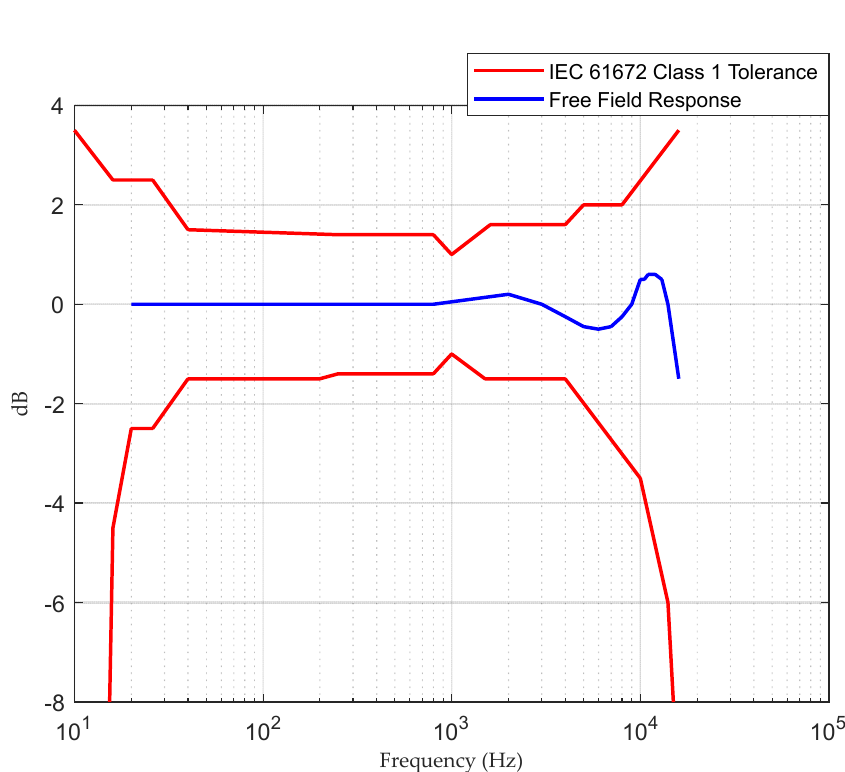
Figure 1. Frequency response of SAS 2000.